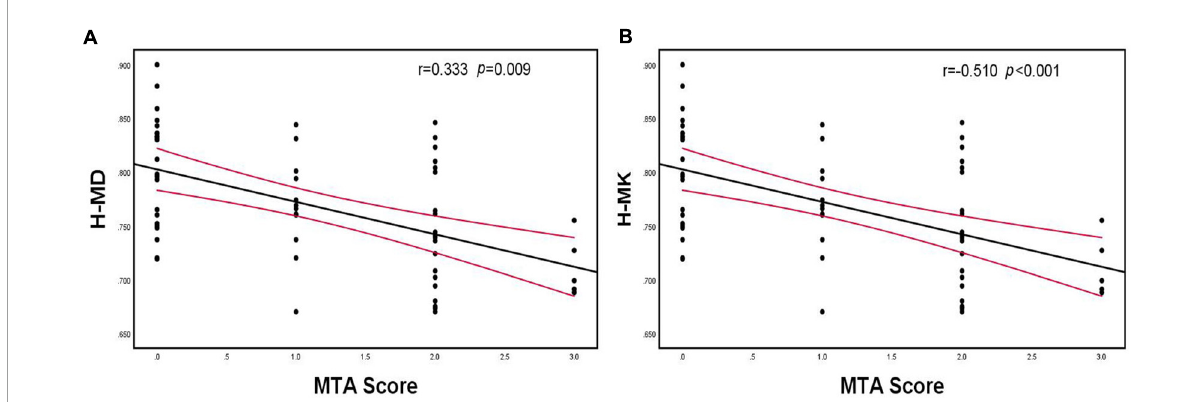
FIGURE5 Spearman’s correlation analysis between MD and MK of the hippocampus and MTA scores. (A) There was a positive correlation between hippocampus MD and MTA scores, (B) There was a negative correlation between hippocampus MK and MTA scores. H-MD, mean diffusivity of hippocampus; H-MK, mean kurtosis of hippocampus; MTA, medial temporal lobe atrophy.